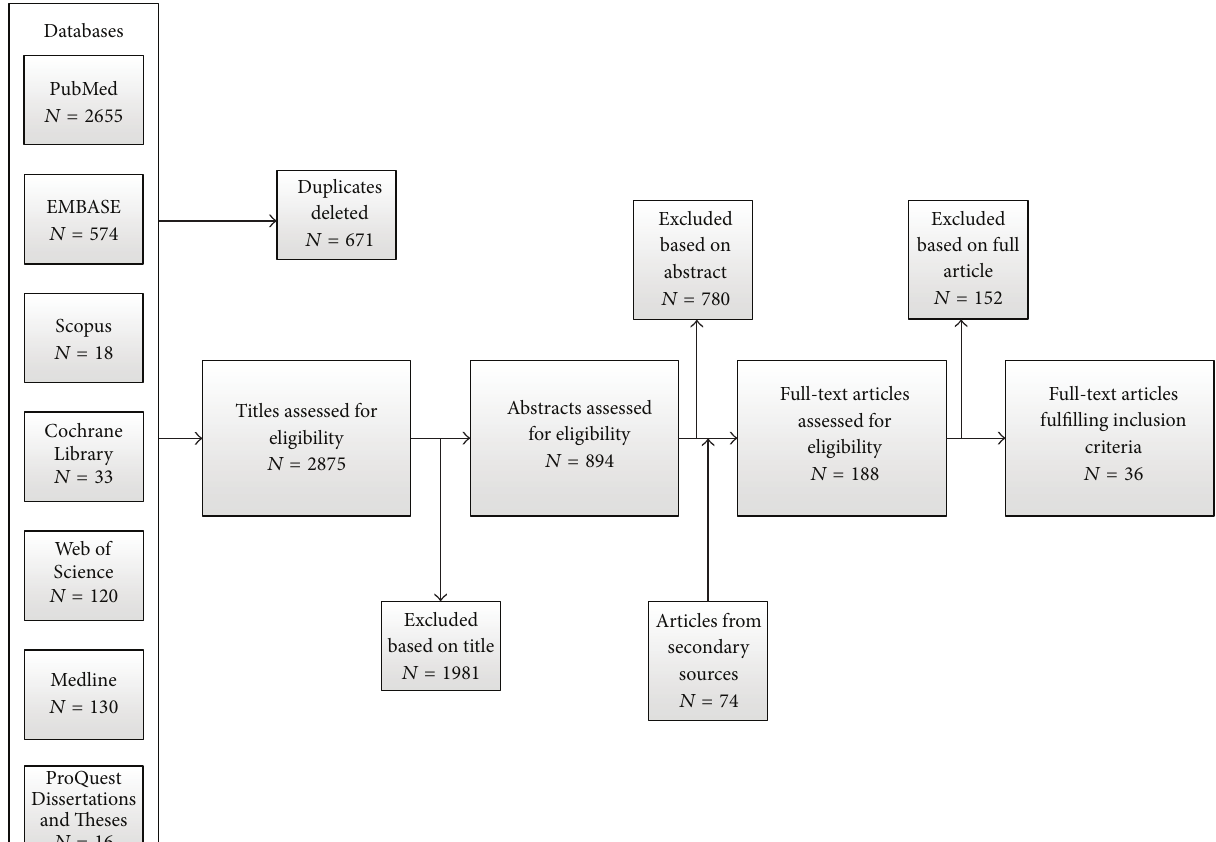
Figure 1: Flowchart depicting the identification of studies, inclusion, and exclusion